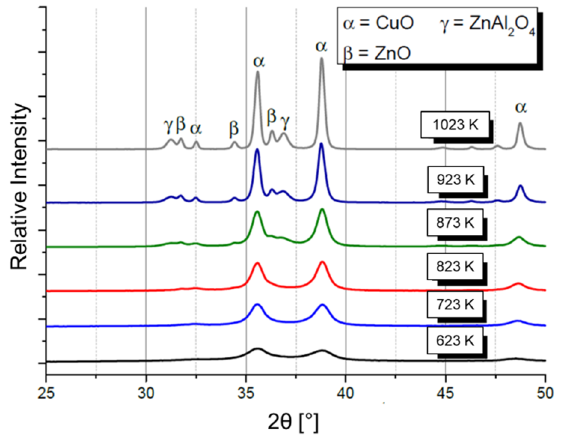
Figure 10. PXRD patterns of the dried catalyst precursors, hydrolyzed using 600 equivalents of water, depending on the calcination temperature. T calc = 2 h, heating rate = 1 K · min − 1 . Catalyst system: Cu 0.61 Zn 0.21 Al 0.18 .